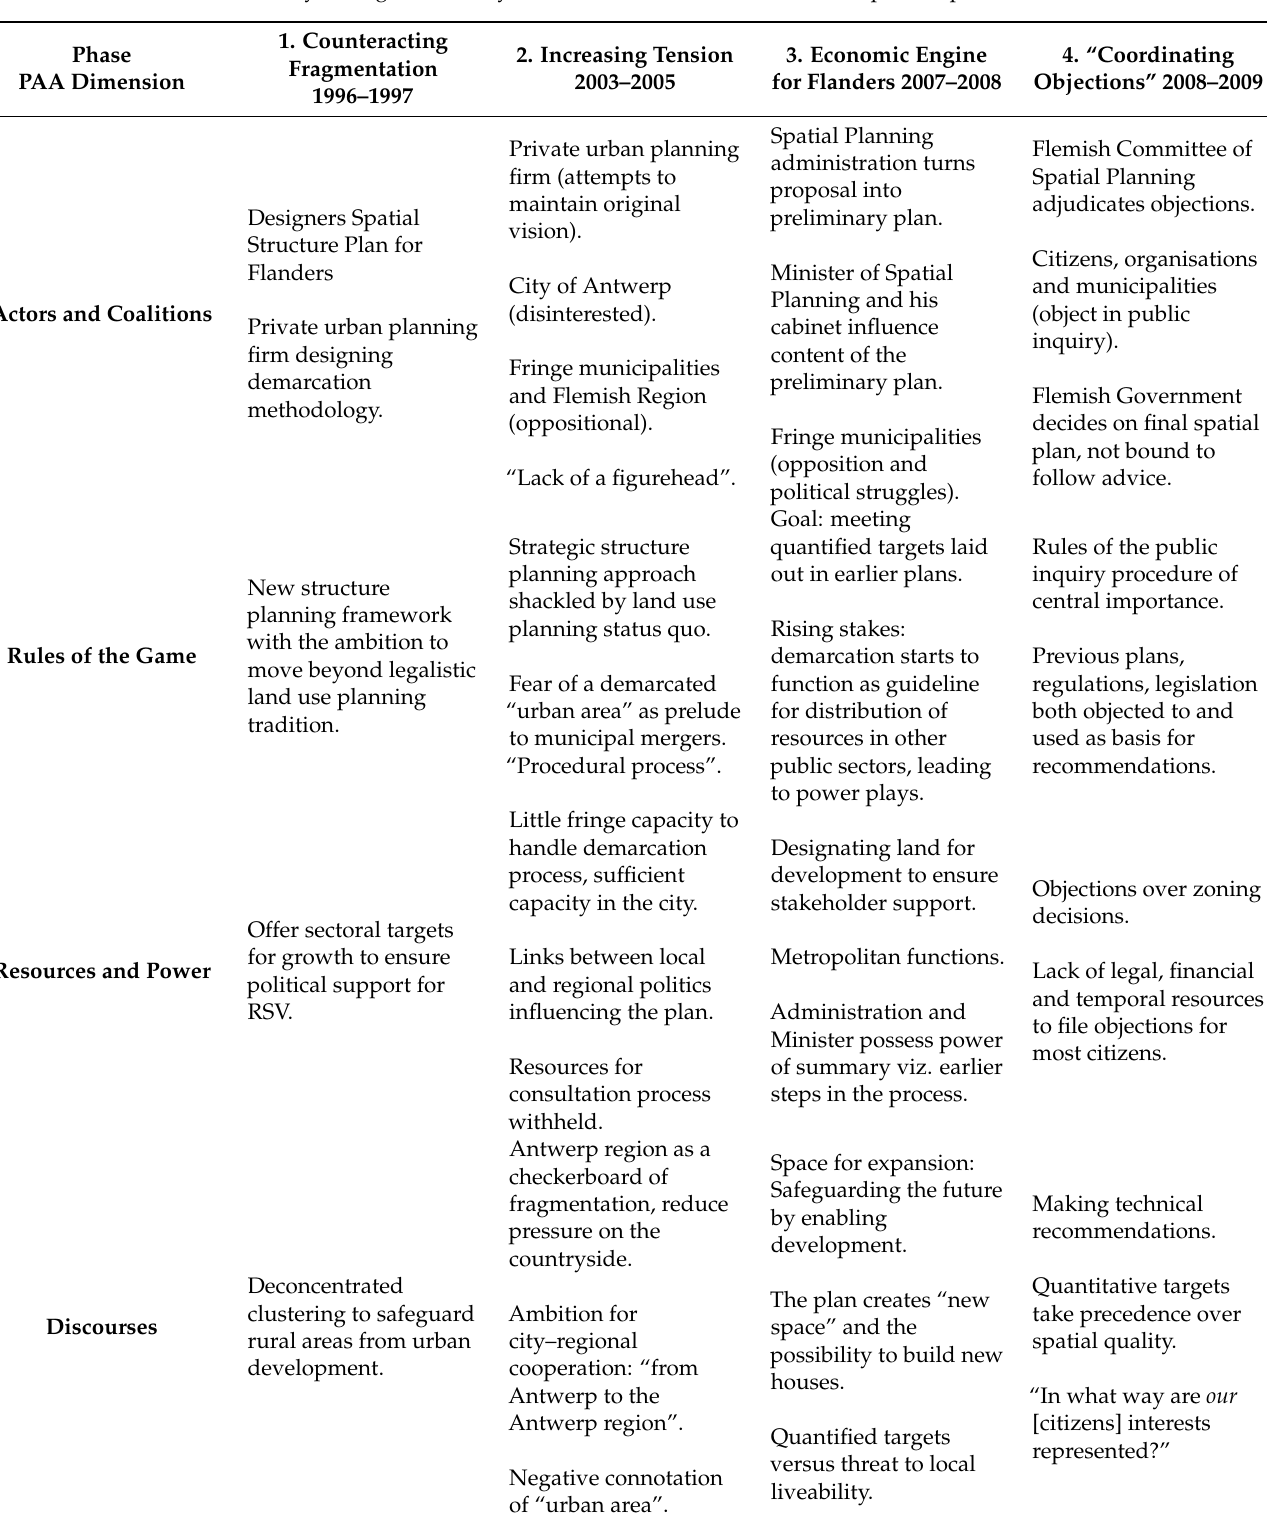
Table 2. Policy arrangement analysis of the demarcation of the Antwerp Metropolitan